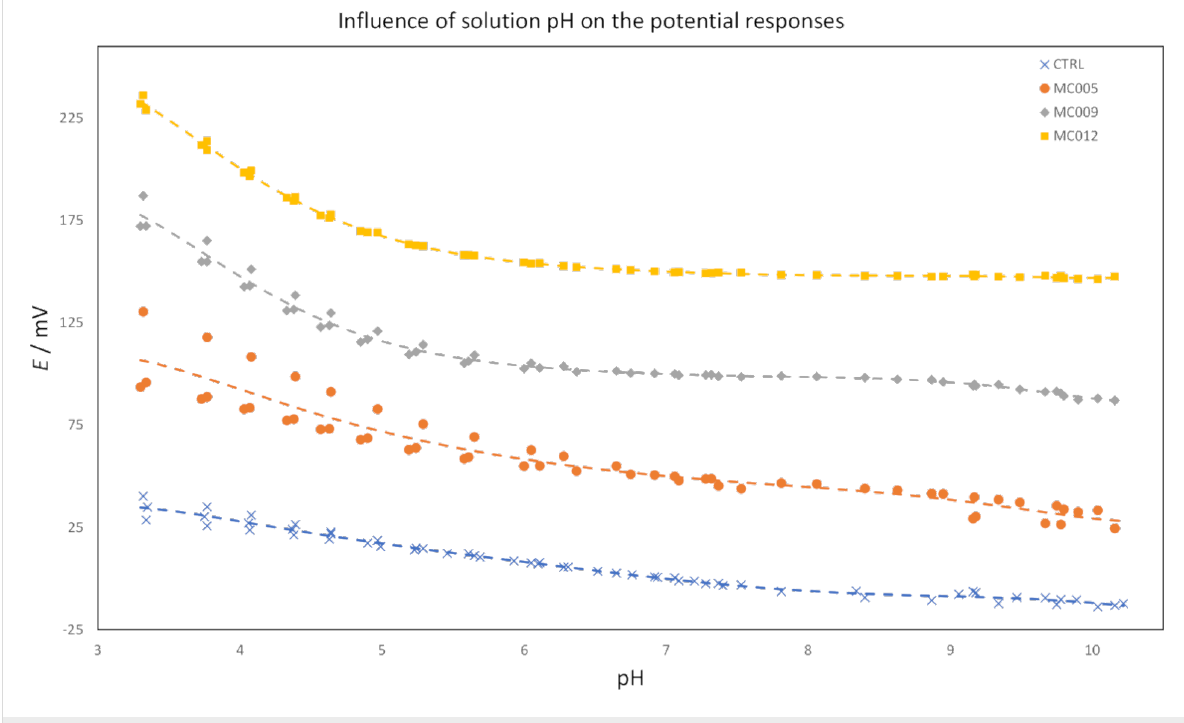
Figure 9: The influence of solution pH on the potential responses of the sensor prototypes (three sensors for each membrane composition). The mea- surements were performed in 0.01 M acetic acid. Potentials have been adjusted to overlap the responses of sensors with the same membrane.